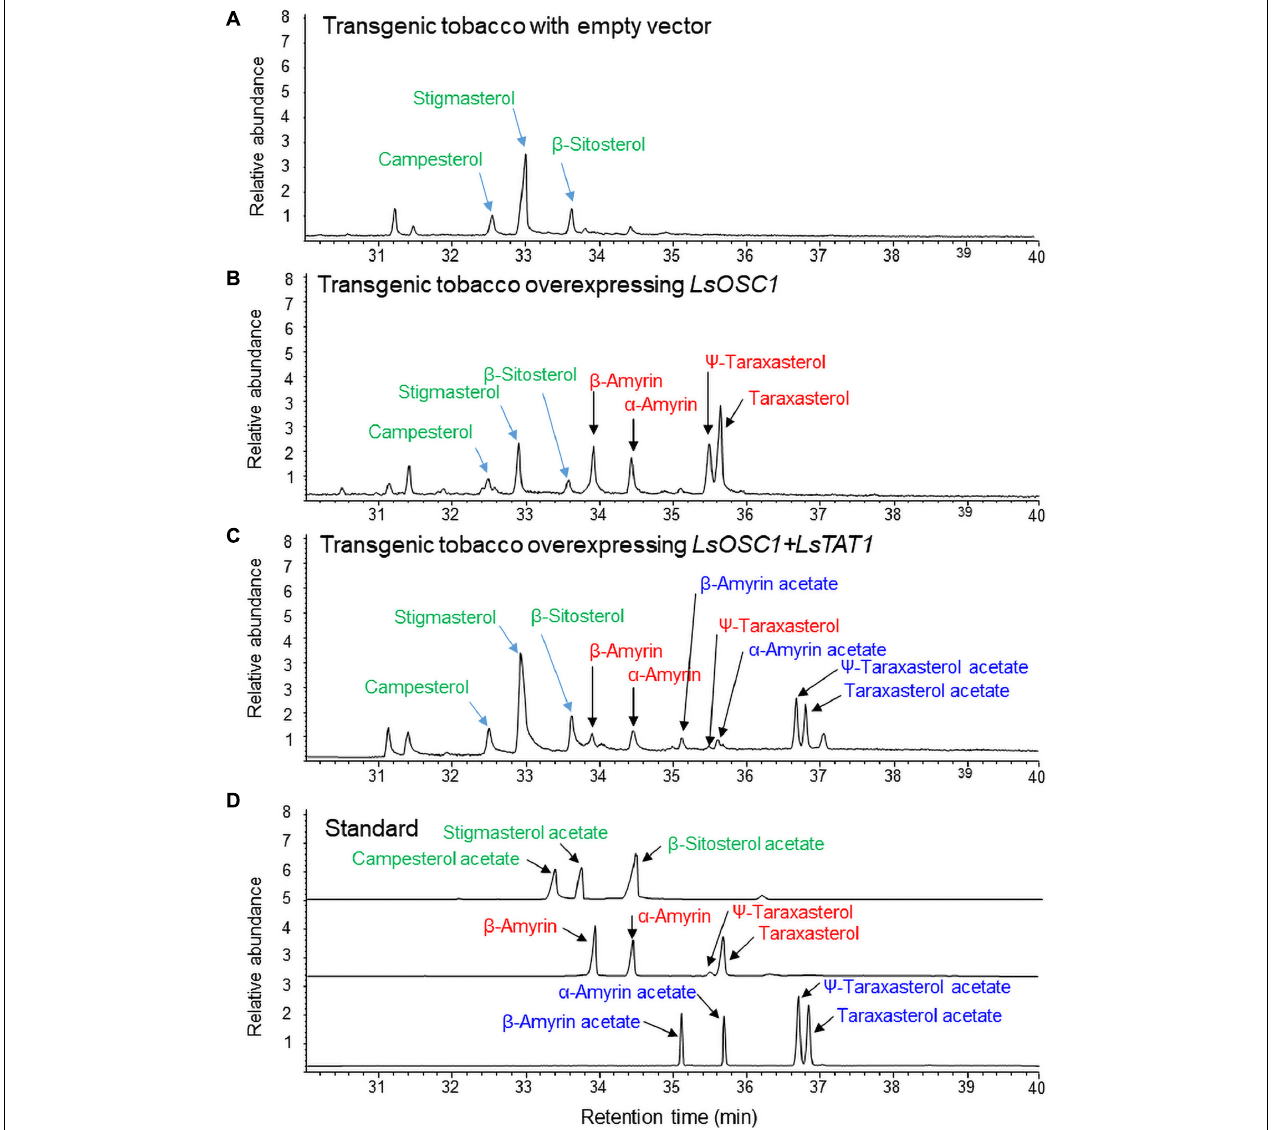
FIGURE 8 | Gas chromatography (GC) analysis of triterpene acetates extracted from leaves of transgenic tobacco co-expressing both the LsOSC1 and LsTAT1 genes. (A) Chromatogram of leaf extracts of control tobacco transformed with the empty vector. (B) Chromatogram of triterpene products ( β -amyrin, α -amyrin, ψ -taraxasterol, taraxasterol, and dammarenediol-II) in transgenic tobacco overexpressing the LsOSC1 gene. (C) Chromatogram of triterpene acetates (taraxasterol acetate and ψ -taraxasterol acetate) in transgenic tobacco overexpressing both the LsOSC1 and LsTAT1 genes. (D) GC chromatograph of authentic standards of β -amyrin acetate, α -amyrin acetate, ψ -taraxasterol acetate, and taraxasterol